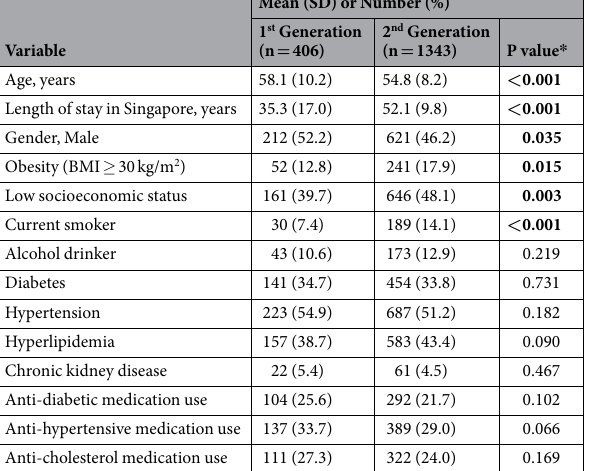
Table 1. Comparison of baseline characteristics of participants by generation status in SINDI (N = 1749 # ). * Mann-Whitney U test or chi-squared test. # 1749 individuals had no CVD at baseline, had complete data for all baseline characteristics including generation status and returned for follow-up. Low socioeconomic status was defined as primary or lower education, and individual monthly income < SGD2000. Bolded values indicate statistically significant results.